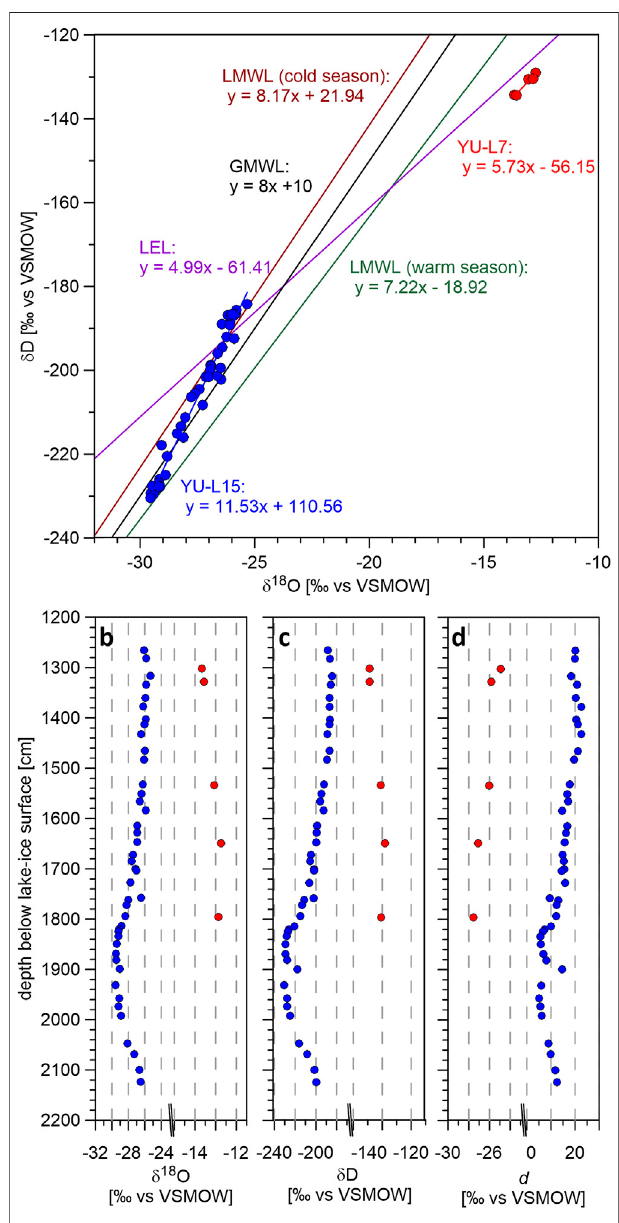
FIGURE 8 | Stable water isotopes of the alas lake core YU-L7 (red dots) and the Yedoma lake core YU-L15 (blue dots) samples. (A) Scatter plot of δ 18 Oand δ D.IndicatedaretheGMWL(black),theLEL(purple),andtheLMWL of Yakutsk for the warm season (green) and the cold season (brown). (B – D) δ 18 O, δ D, and d (deuterium excess), respectively, against core depth. Note the breaks on the x-axes in (B – D)